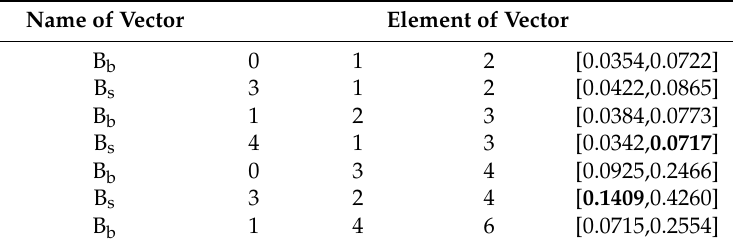
Table 5. Identification template 1 for forest class.